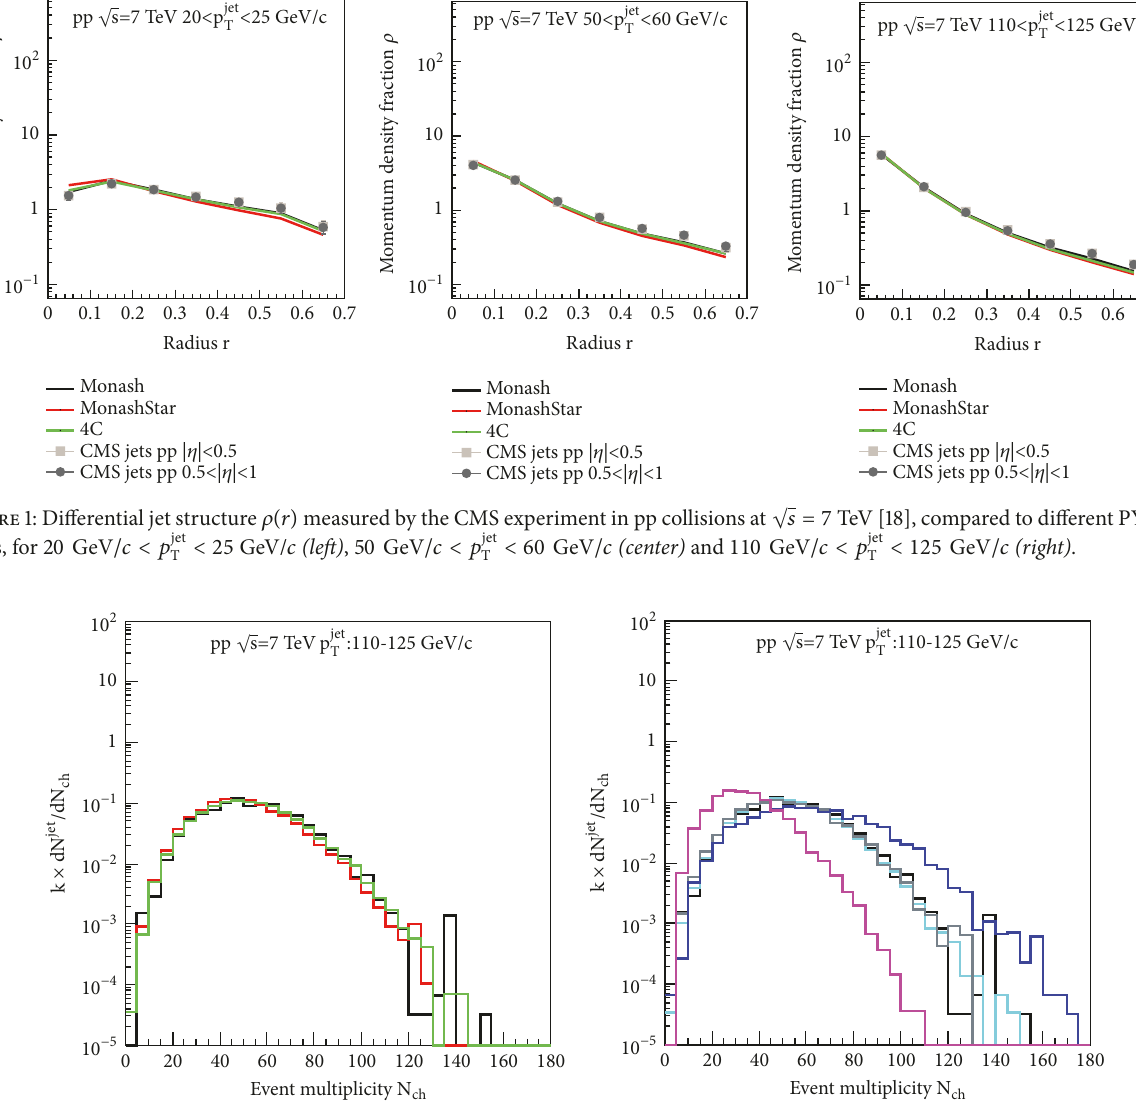
Figure 2: Distributions of event multiplicity for jets in the 110 GeV /𝑐 < 𝑝 jet and 4C tunes (left) and for the Monash tune with the CR0, CR1, CR2, and settings as well as CR turned off and MPI turned off (right)